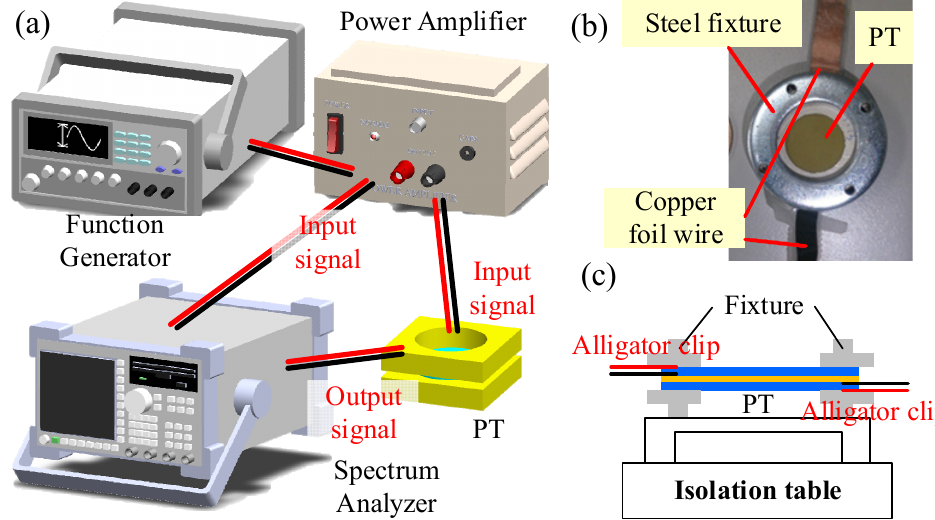
Figure 3. ( a ) The experimental setup ( b ) the specimen of PT ( c ) the fixture and